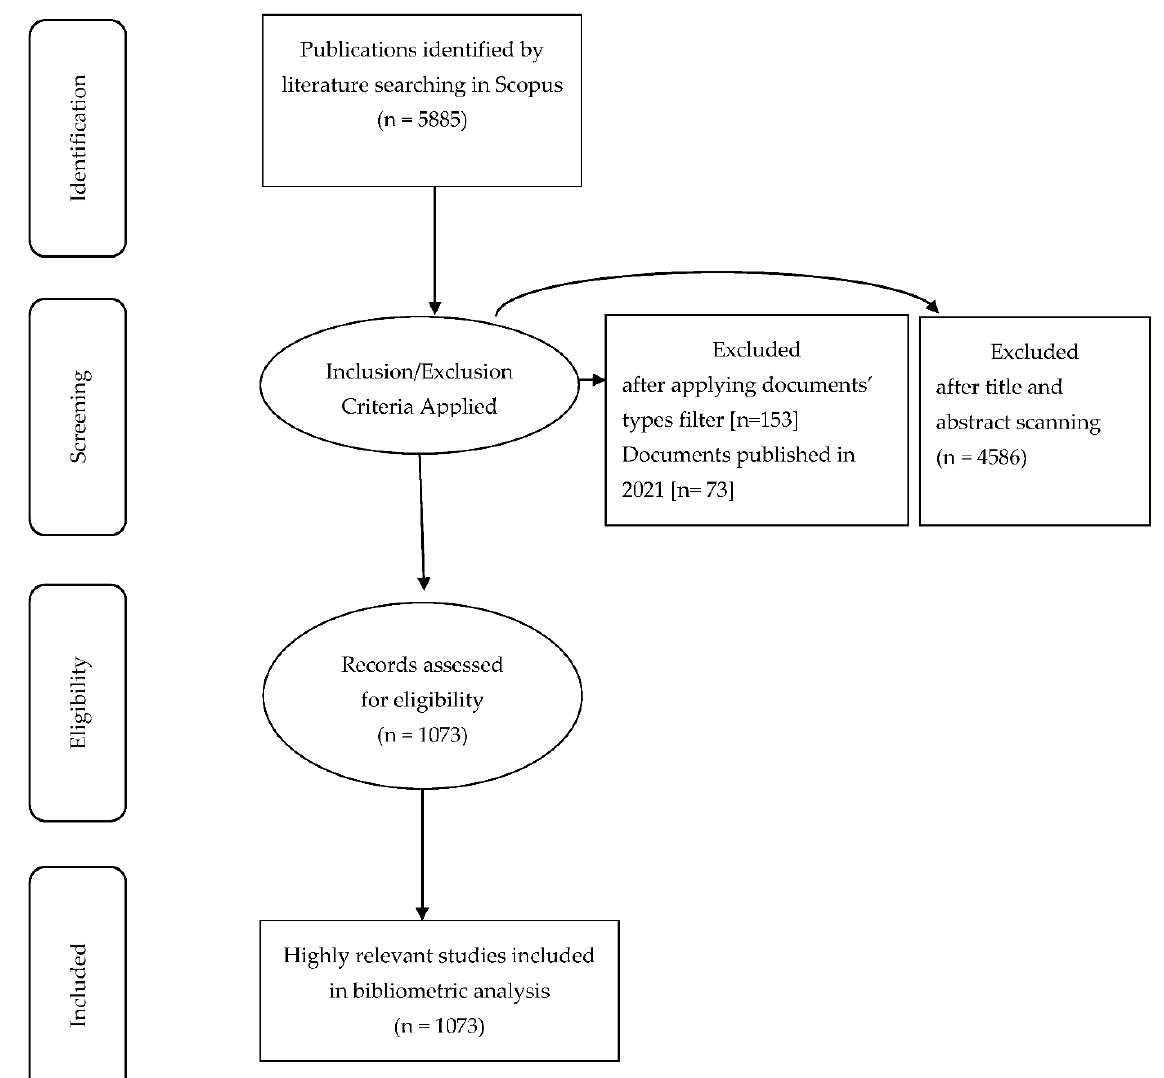
Figure 1. Four phase flow chart of the data extraction and filtration process.